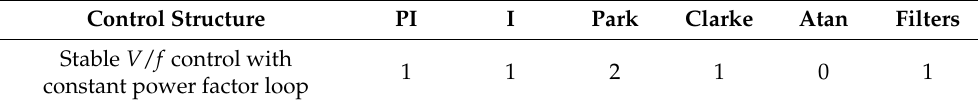
Table 2. Stable V / f control with constant power factor